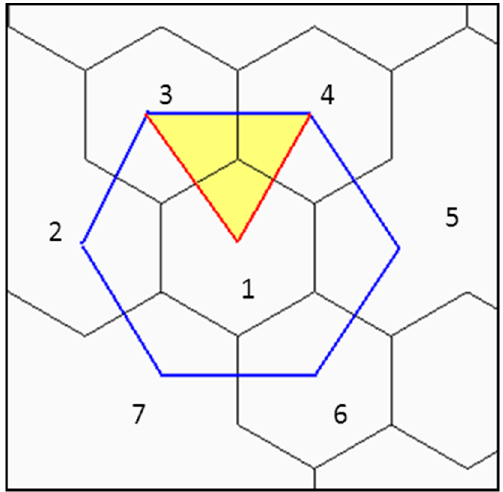
Figure 2. Buffering used to define core area. The area within the triangle will provide core area only when stands 1, 3 and 4 all meet the requirements for Kirtland’s warbler breeding habitat. Area within larger hexagon surrounding stand 1 depends on condition of stand 1 for producing core area. The 0.81 ha hexagons used in this study have an average buffer distance of 37 m; the distance between the boundary of stand 1 and the larger hexagon around